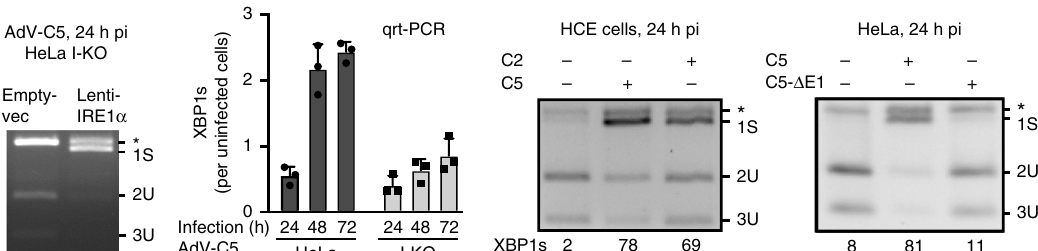
Fig. 1 IRE1 α activation enhances AdV infection of HeLa cells. a IRE1 α -knockout (I-KO) HeLa cells are less susceptible to infection by AdV-C5 (MOI 75, 75 vp/cell) compared with normal HeLa, as indicated by late viral protein VI expression, whereas the ectopic lentivirus-mediated expression of IRE1 α in HeLa I-KO cells restores infection (left panel, upper row middle and right panels showing representative images and quanti fi cations, respectively. Scale bar, 200 µ m). Data show the means ± SD from four independent experiments. Reduced virus growth in HeLa I-KO cells compared with wild-type cells. Cells were infected with AdV-C5 (MOI 500) for 1 h at 37 °C (equivalent to MOI 50 in continuous infection), unbound virus washed off, and virus titers from cells and supernatant measured at 48 and 72 hpi (lower row middle panel). Data show the means from two independent experiments. The IRE1 α endonuclease inhibitor 4 µ 8C reduces AdV-C5 titers in long-term infections of HDF-TERT cells (lower row, right panel). HDF-TERT cells were infected with AdV-C5 (MOI 200, 37 °C, 1 h), followed by addition of 4 µ 8C (100 µ M) 13 days pi. Data show the means from two independent experiments. b . IRE1 α and the expression of the viral E1A protein are required to enhance XBP1 splicing in AdV-C2 and C5 infections. Rescue of XBP1 splicing in AdV-infected I-KO cells by IRE1 α overexpression ( fi rst panel). Cells were transduced and infected as in a ; cell lysates were subjected to XBP1 splicing assays at 24 hpi. Reduced XBP1s transcripts in HeLa I-KO compared with normal HeLa cells upon AdV-C5 infection (MOI 5, second panel). Data show the means± SD from three independent experiments. XBP1 splicing in human conjunctival epithelial cells infected with AdV-C2 or C5 (MOI 75, third panel). E1A -deleted AdV-C5 mutant does not activate XBP1 splicing in HeLa cells 24 hpi (MOI 200 each, fourth panel). The asterisk denotes a background product. Source data are provided as a Source Data fi